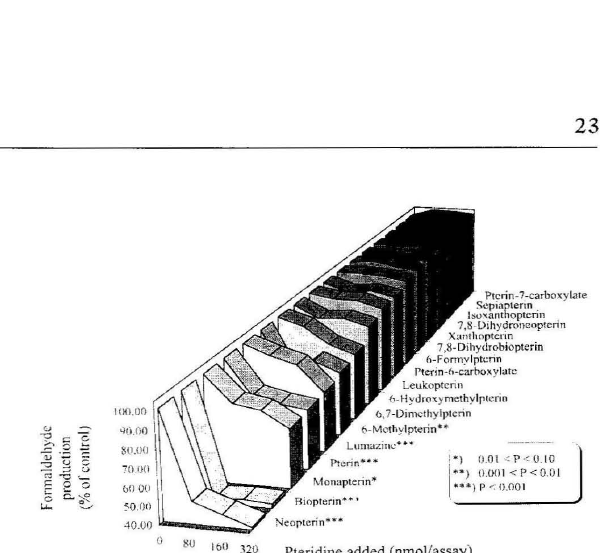
Figure 2. Effects of pteridines on cytochrome P450-medi ared degradation of aminoantipyrin. Shown are mean ef fcets of four to SL" separate experiments using different con centrations of pteridines for an incubation time of 20 min